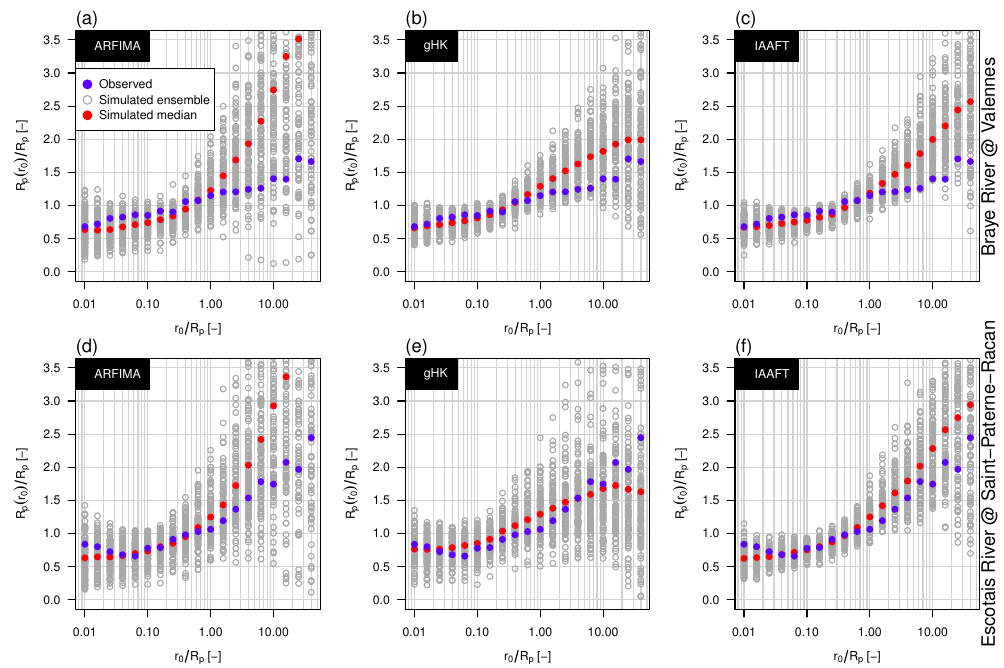
Figure 14. Standardized conditional return periods versus conditioning values of return intervals. Blue points correspond to the observed series, grey circles denote to an ensemble of 100 simulated time series with the same length of the observed ones, and red points denote the simulated median patterns. Panels ( a – c ) refer to the Braye River while panels ( d – f ) to the Escotais River. The same interpretation of Figure 11